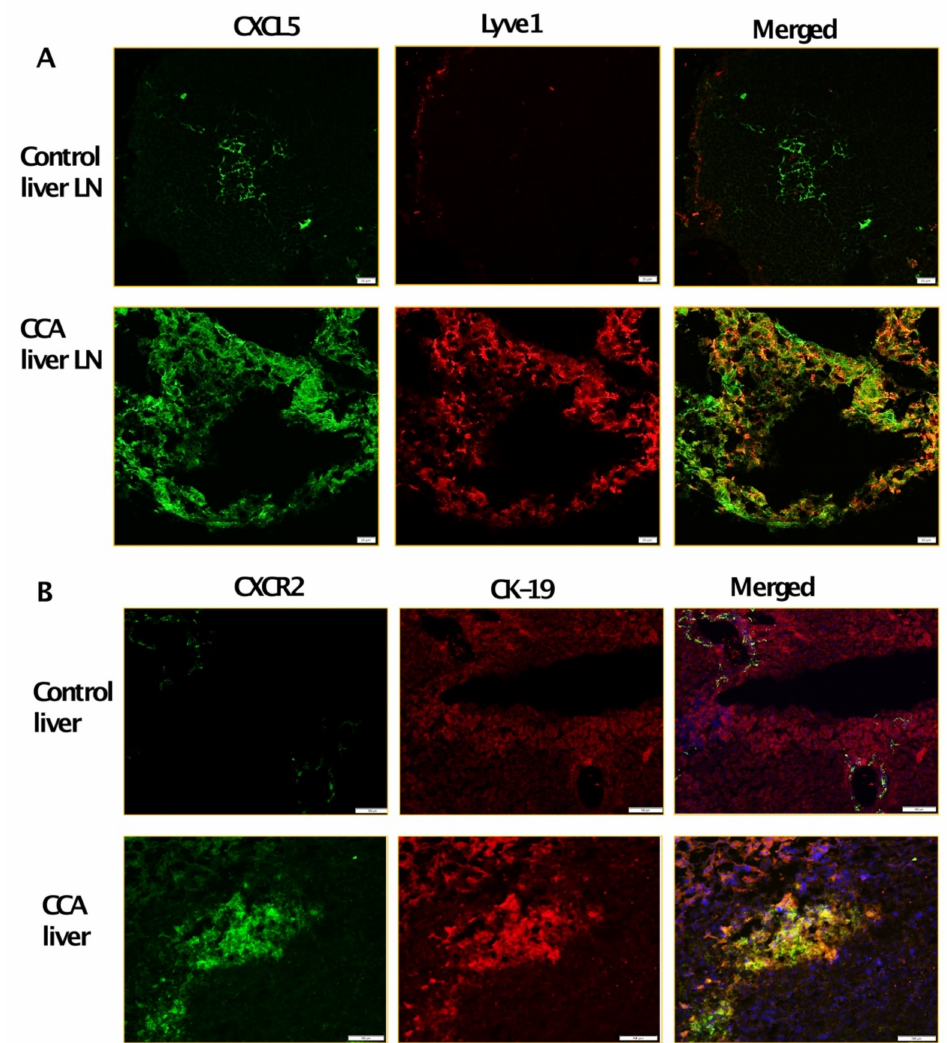
Figure 3. Tumor draining liver LNs and tumor liver express high levels of CXCL5 and CXCR2. Representative immunofluorescent images at 40 × magnification of ( A ) CXCL5 expression (green fluorescence) and LYVE1 expression (red fluorescence) in liver LN of control and orthotopic CCA mice. Scale bars are 20 µ m. Representative immunofluorescent images at 10 × magnification of ( B ) CXCR2 expression green fluorescence) and CK19 expression (red fluorescence) in control liver and tumor from control and orthotopic CCA mice respectively. Scale bars are 100 µ m. At least 3–5 images were taken for all tissue